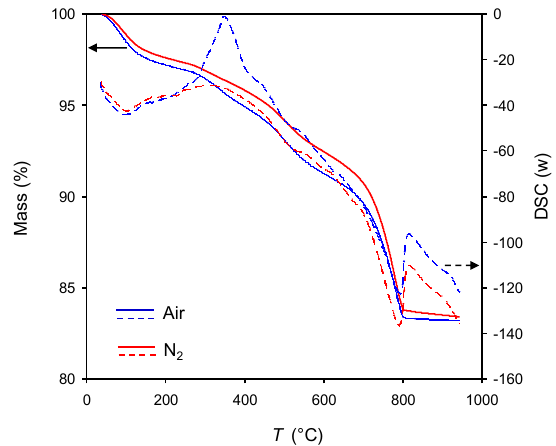
Figure 10. TG/DSC traces of Saharan dust collected in air (blue curves) and in inert N 2 (red curves)